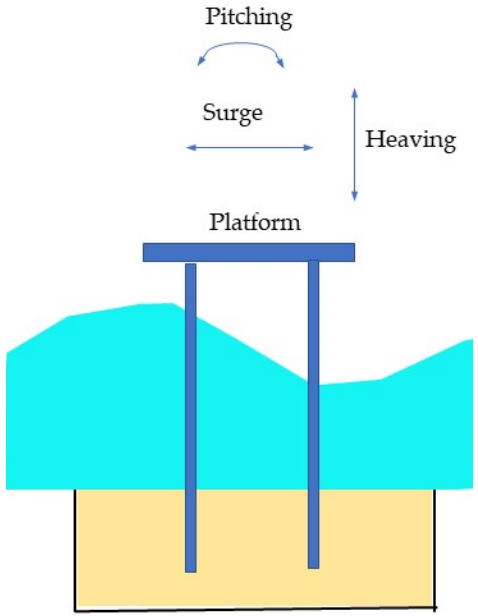
Figure 11. Schematic diagram of the platform’s motion under wave action.